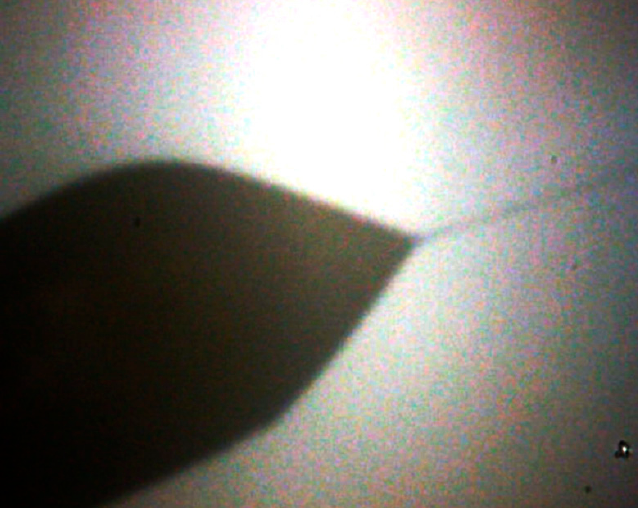
Figure 3. Formation of the Taylor cone.